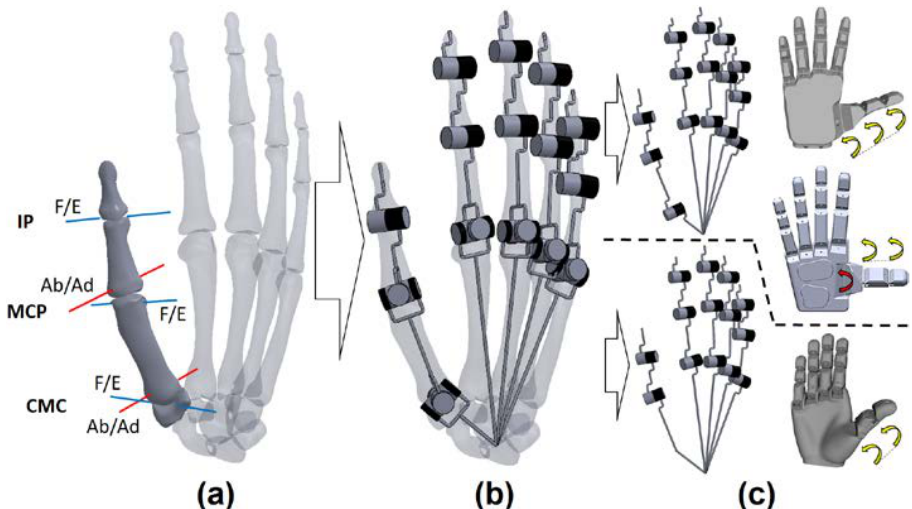
Figure 1. ( a ) Joints of the human thumb; ( b ) idealised kinematic chain (KC) for artificial hands; ( c ) simplified KCs for the Dextrus, IMMA, and Limbitless hands, as shown from top to bottom. Yellow arrows: several DOF actuated by the same actuator (underactuation); red arrows: DOF actuated by one independent actuator.